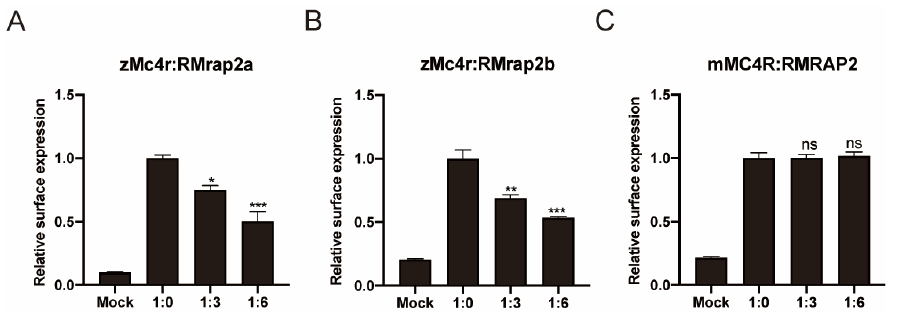
Figure 4. Inhibition of the membrane trafficking of zMc4r by RMrap2a and RMrap2b. ( A – C ) The surface expression of zMc4r ( A , B ) and mMC4R ( C ) with the increasing dosages of RMrap2a/b and RMRAP2. Mock: blank control transfected with pcDNA3.1. Data were analyzed by one-way ANOVA and are shown as mean ± SEM of three replicates. ns (not significant difference), * p < 0.05, ** p < 0.01 and *** p < 0.001.